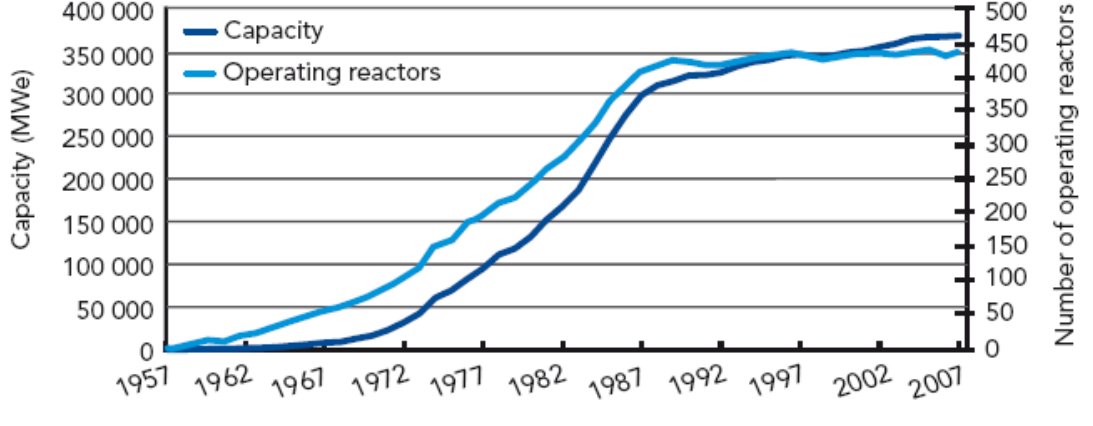
Figure 28. Age distribution of operating nuclear plants. © 2008 OECD, reproduced with permission from